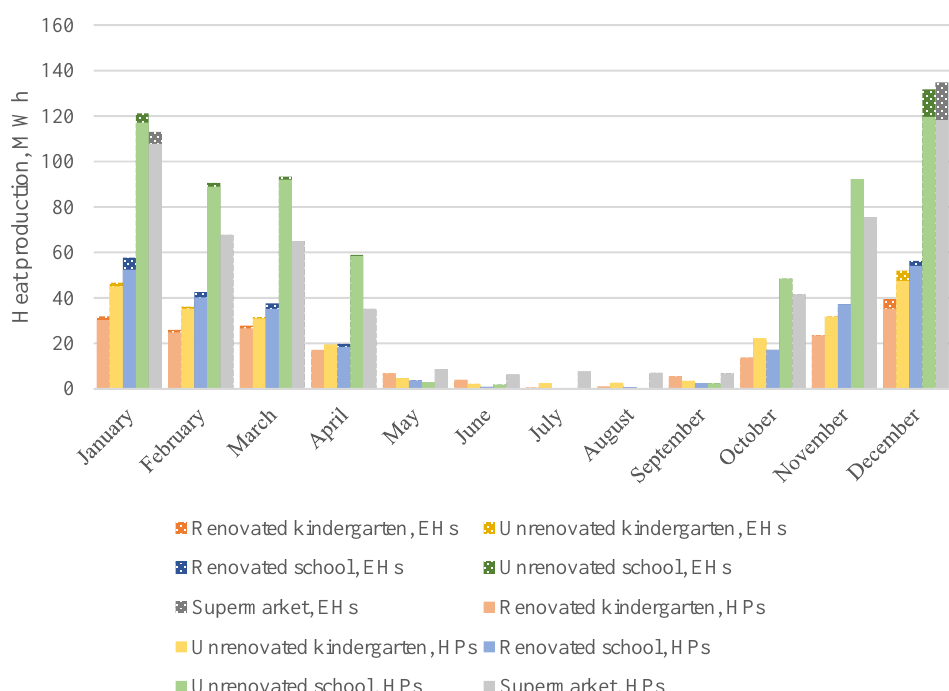
Figure 9. Comparison of heat production in renovated and unrenovated schools, kindergartens, and supermarket.